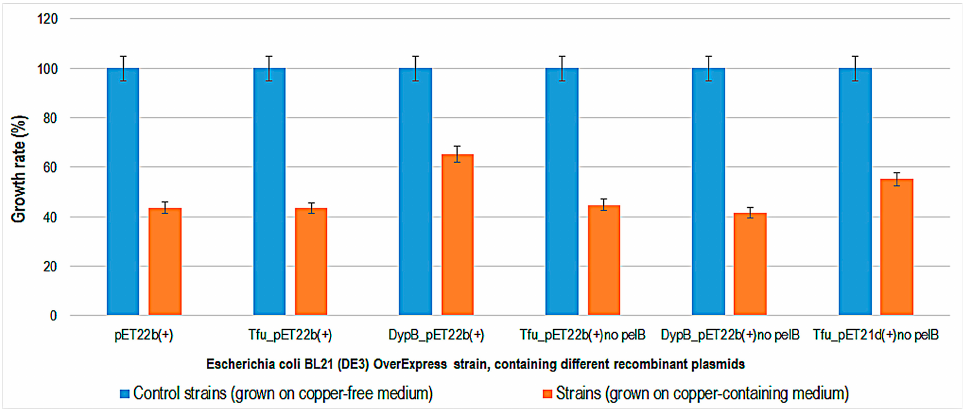
Figure 3. Growth rate (%) for Escherichia coli OverExpress containing different recombinant plasmids, after 48 h of expression in Luria-Bertani-isopropyl β -D-1-thiogalactopyranoside-ampicillin medium without and with copper (1 mM).